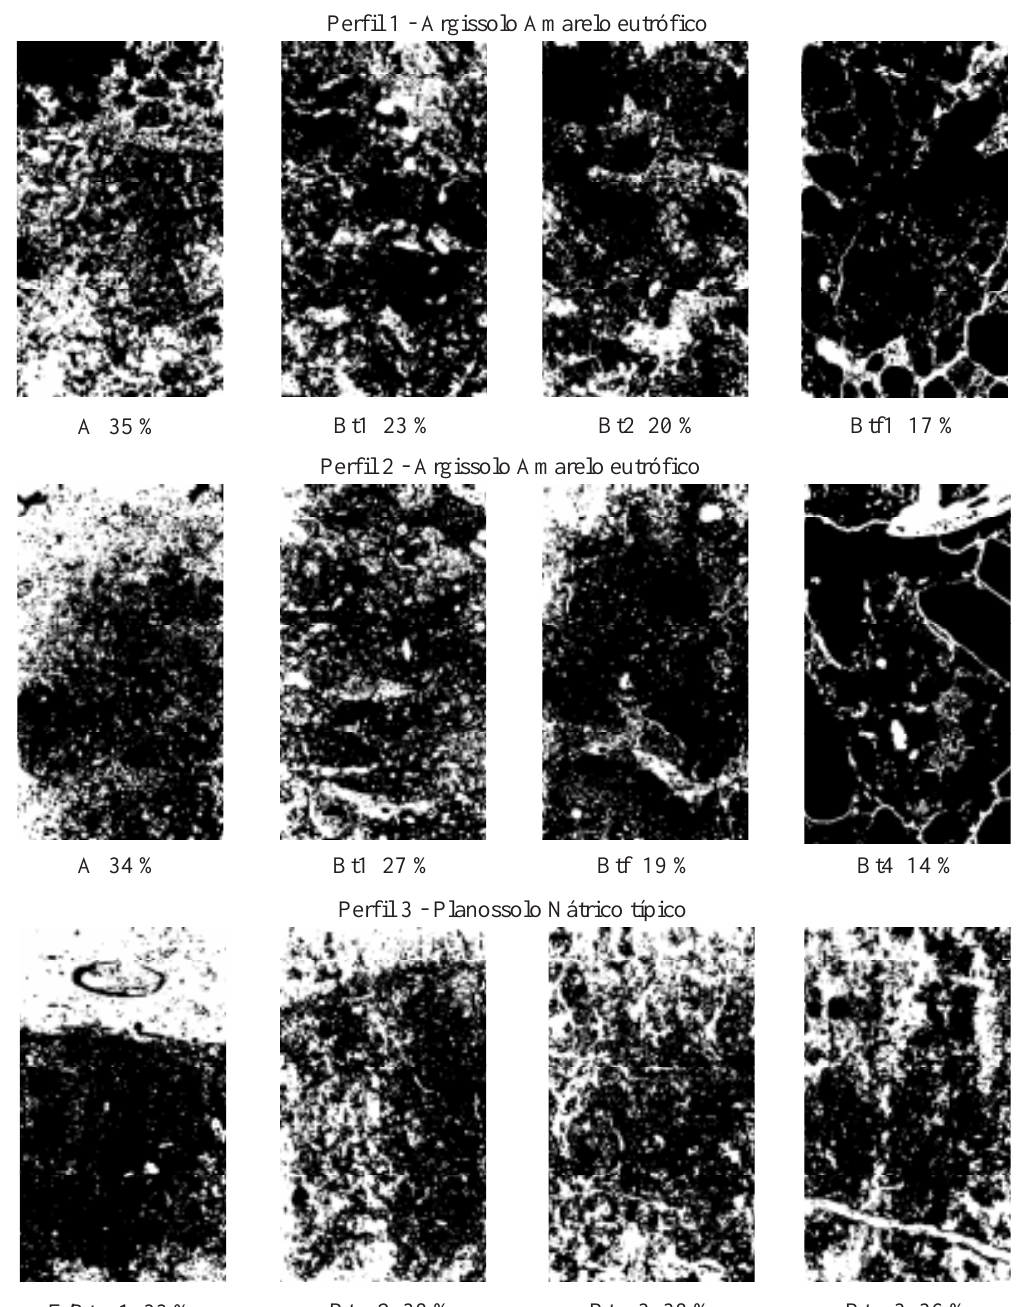
Figura 6. Distribuição do percentual de porosidade (áreas brancas) nos blocos de solo impregnados com resina de poliéster e corante UV, após iluminação com luz